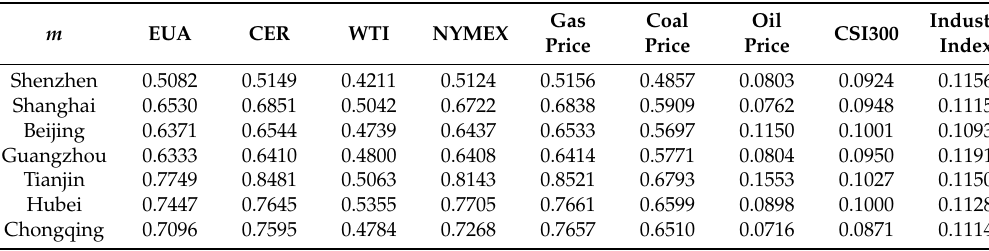
Table 4. Correlation degree.